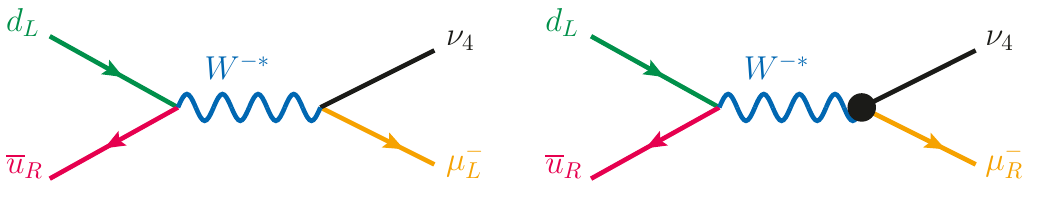
Figure 2 . Lowest order, Born graph depicting du → W −∗ → µ − ν 4 scattering with leading helicity configurations (subscripts) in ν SMEFT at dimension d = 4 (L) and d = 6 (R). Drawn using JaxoDraw